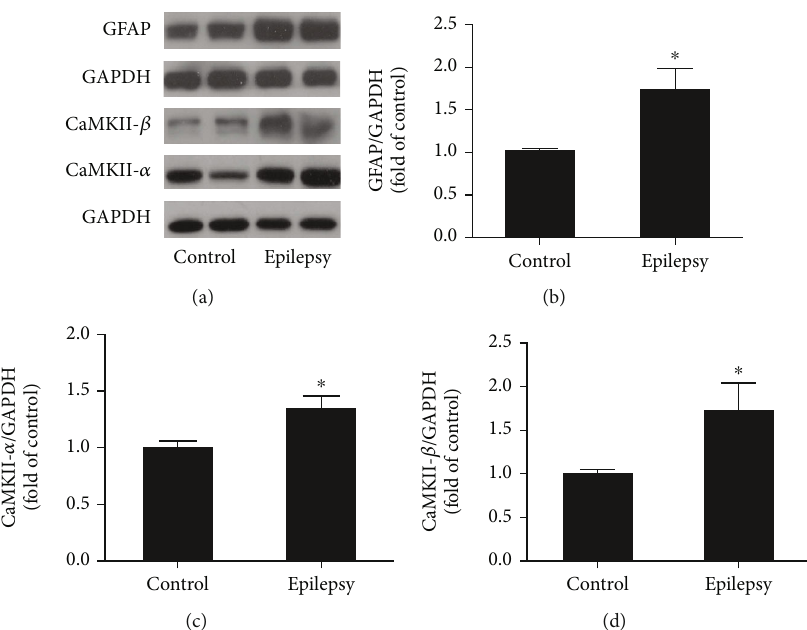
Figure 3: The validation of the pronounced DEPs in the hippocampus of TLE rats. (a) The expression of CaMKII- α , II- β , and GFAP in hippocampus; (b – d) the quantitative analysis of CaMKII- α , II- β , and GFAP. ∗ P < 0 : 05 , control vs. epilepsy ( mean ± SD , n = 5 ). n refers to the numbers of